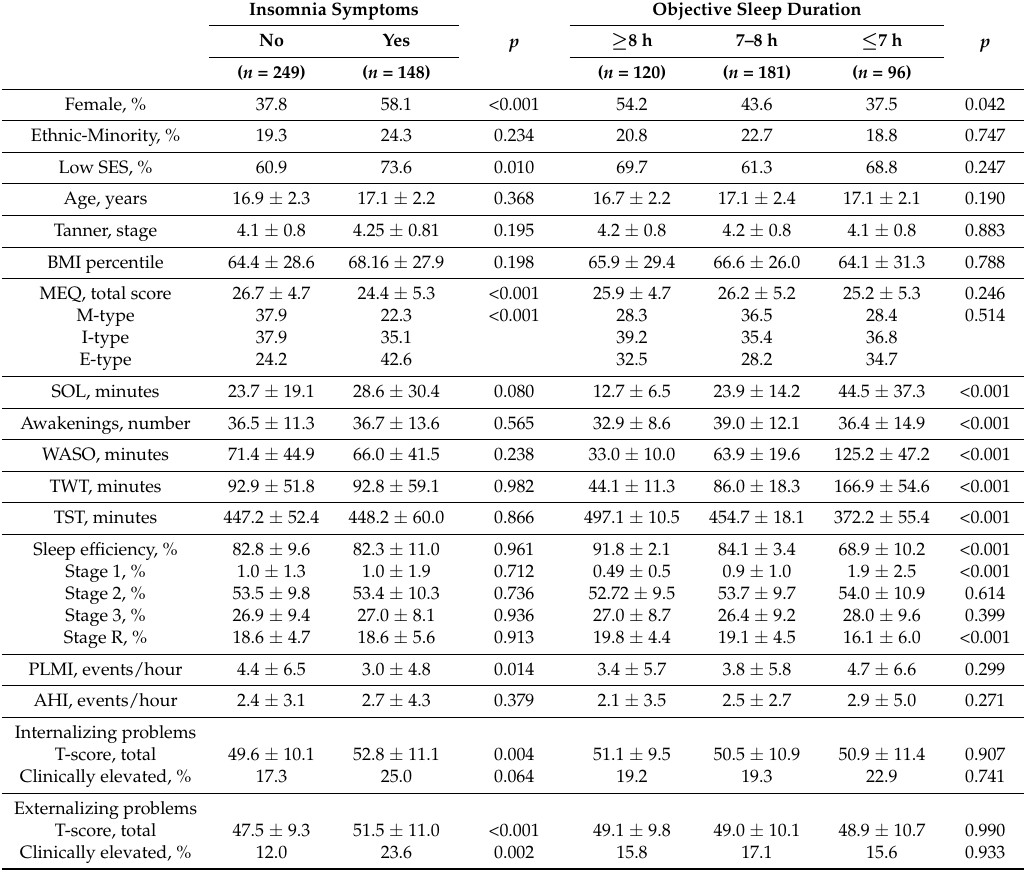
Table 1. Demographic, clinical and polysomnographic characteristics of the sample stratified by insomnia symptoms and objective sleep